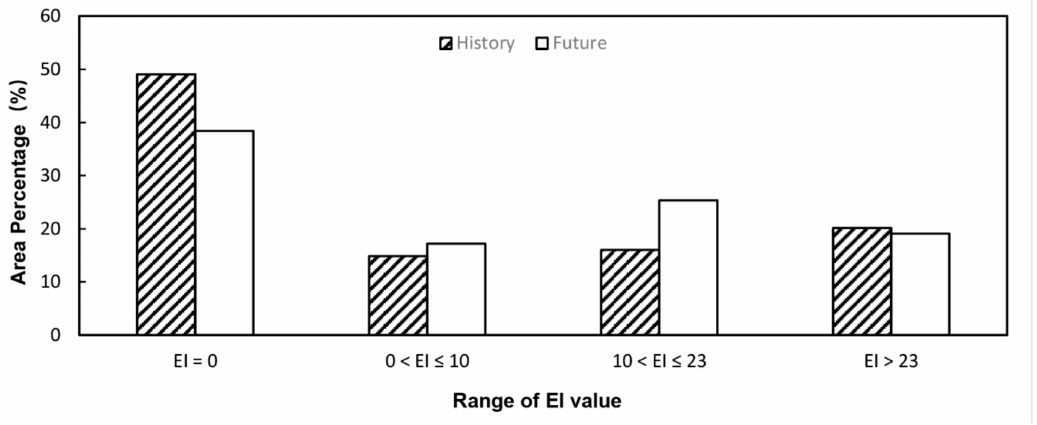
Figure 5. Area proportions of di ff erent ranges of EI values for C. vesuviana under historical and future climate conditions.